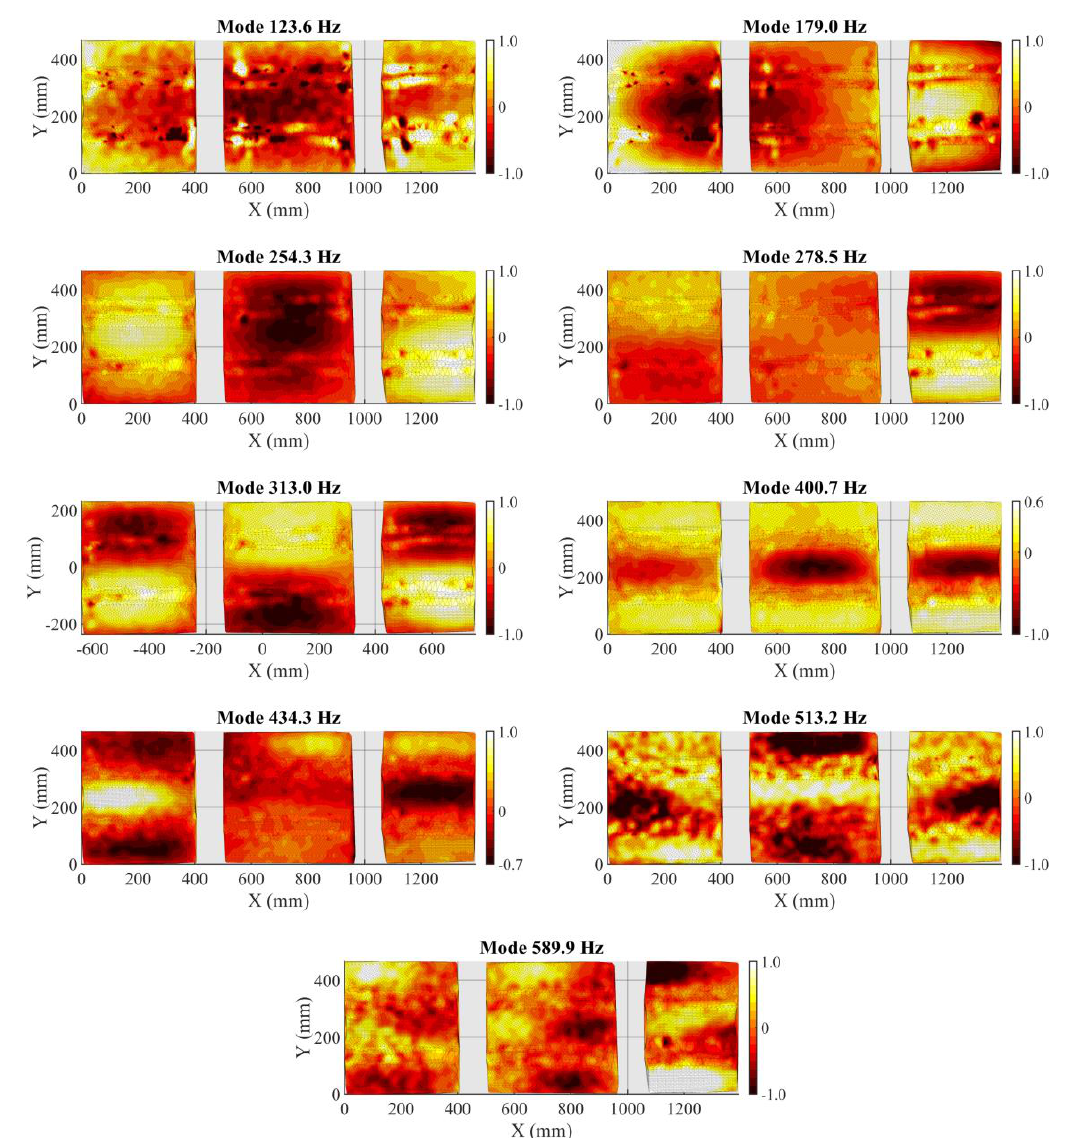
Figure 8. Full-field mode shapes of the CFRP aeronautical panel using OMA.